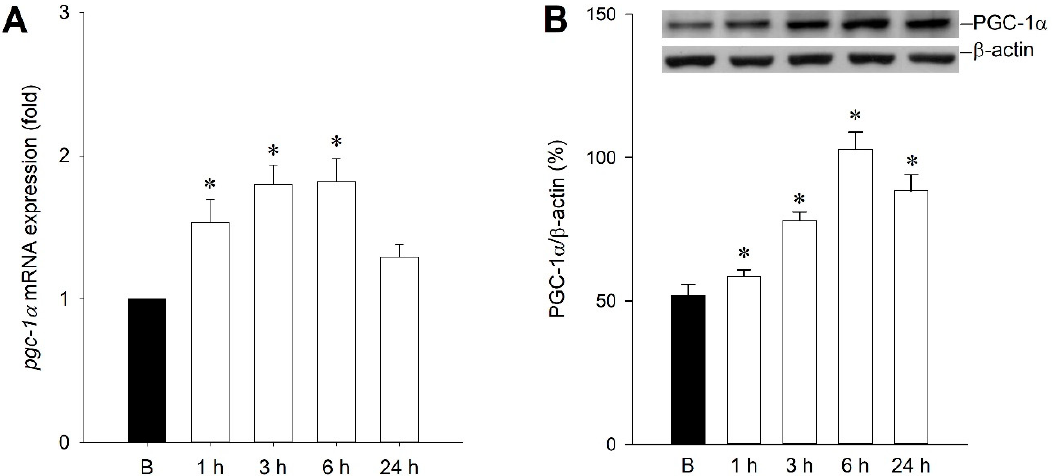
Figure 1. ( A ) Upregulation of expression of pgc-1 α mRNA, and ( B ) changes in PGC-1 α protein relative to β -actin after microinjection of kainic acid (KA) in hippocampal CA3 subfield. Samples were collected from the right CA3 subfield of the hippocampus at 1, 3, 6, or 24 h after microinjection of 0.5 nmol KA or phosphate buffered saline (PBS) into the left hippocampal CA3 subfield. Values are mean ± standard error of the mean (SEM) of quadruplicate analyses from six animals per experimental group. * p < 0.05 versus sham-control group in the Scheffé multiple-range test.